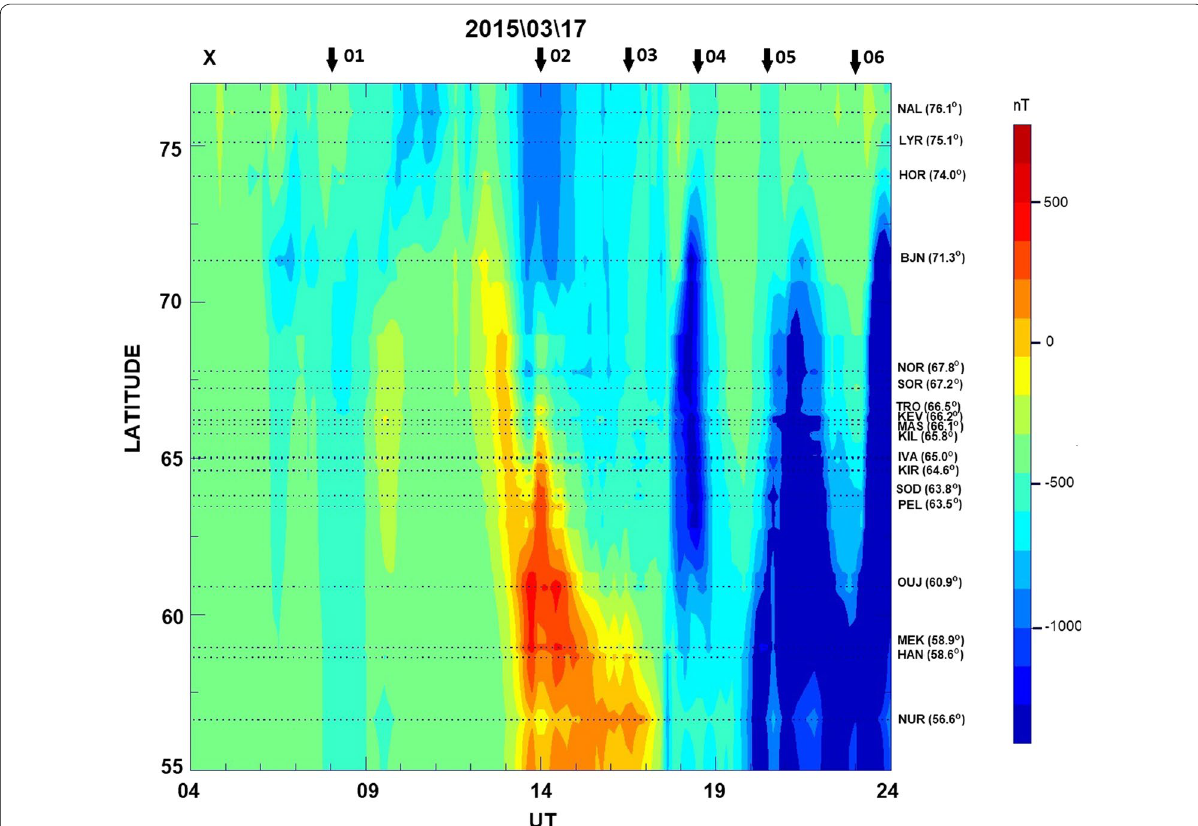
Fig. 6 Magnetic keogram showing the dynamics of latitudinal distribution of magnetic disturbance Δ X along the IMAGE profile during the storm main phase 04–24 UT. Blue color corresponds to the westward electrojet, yellow/red color corresponds to the eastward electrojet. Color coding is saturated to reveal signatures of weaker substorms. Near the right-hand Y -axis, the codes and geomagnetic latitudes of selected IMAGE stations are indicated. Arrows mark substorm #1–6